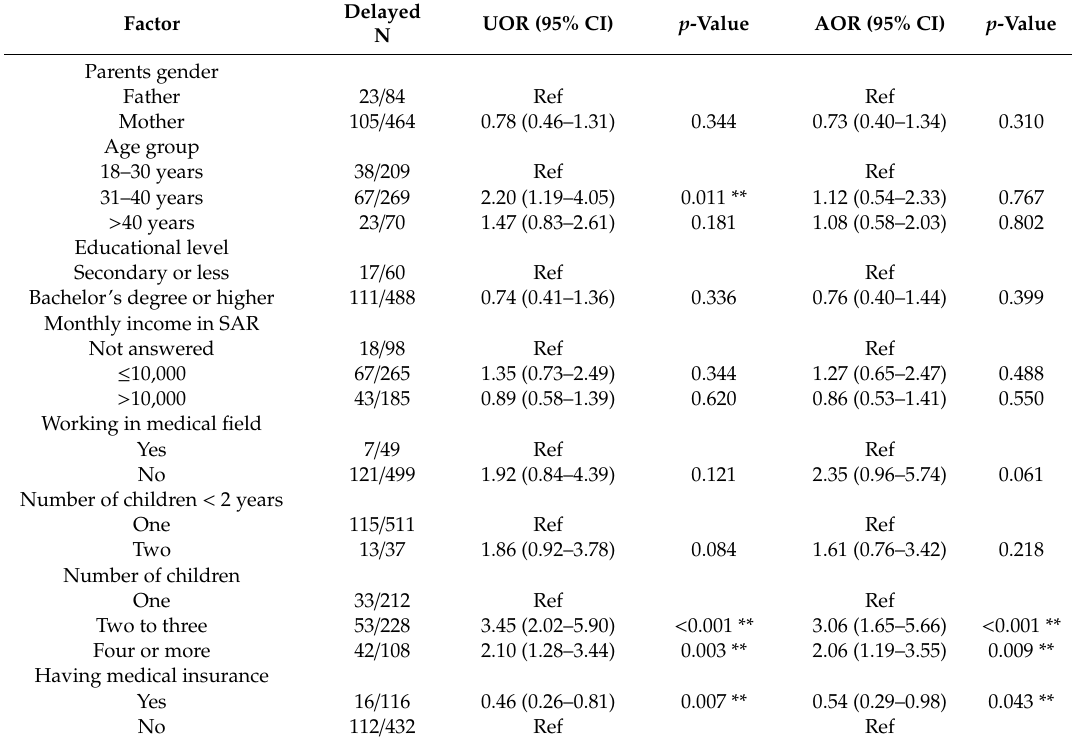
Table 3. Univariate and multivariate regression model for determining factors associated with delayed vaccination (more than one month) ( n =